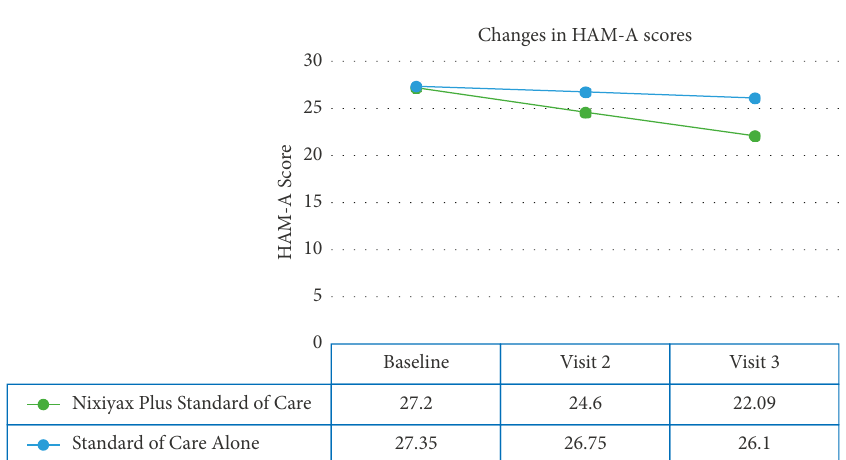
Figure 6: Changes in HAM-A scores. The Lactium ™ plus standard of care group had lower HAM-A scores than the standard of care alone